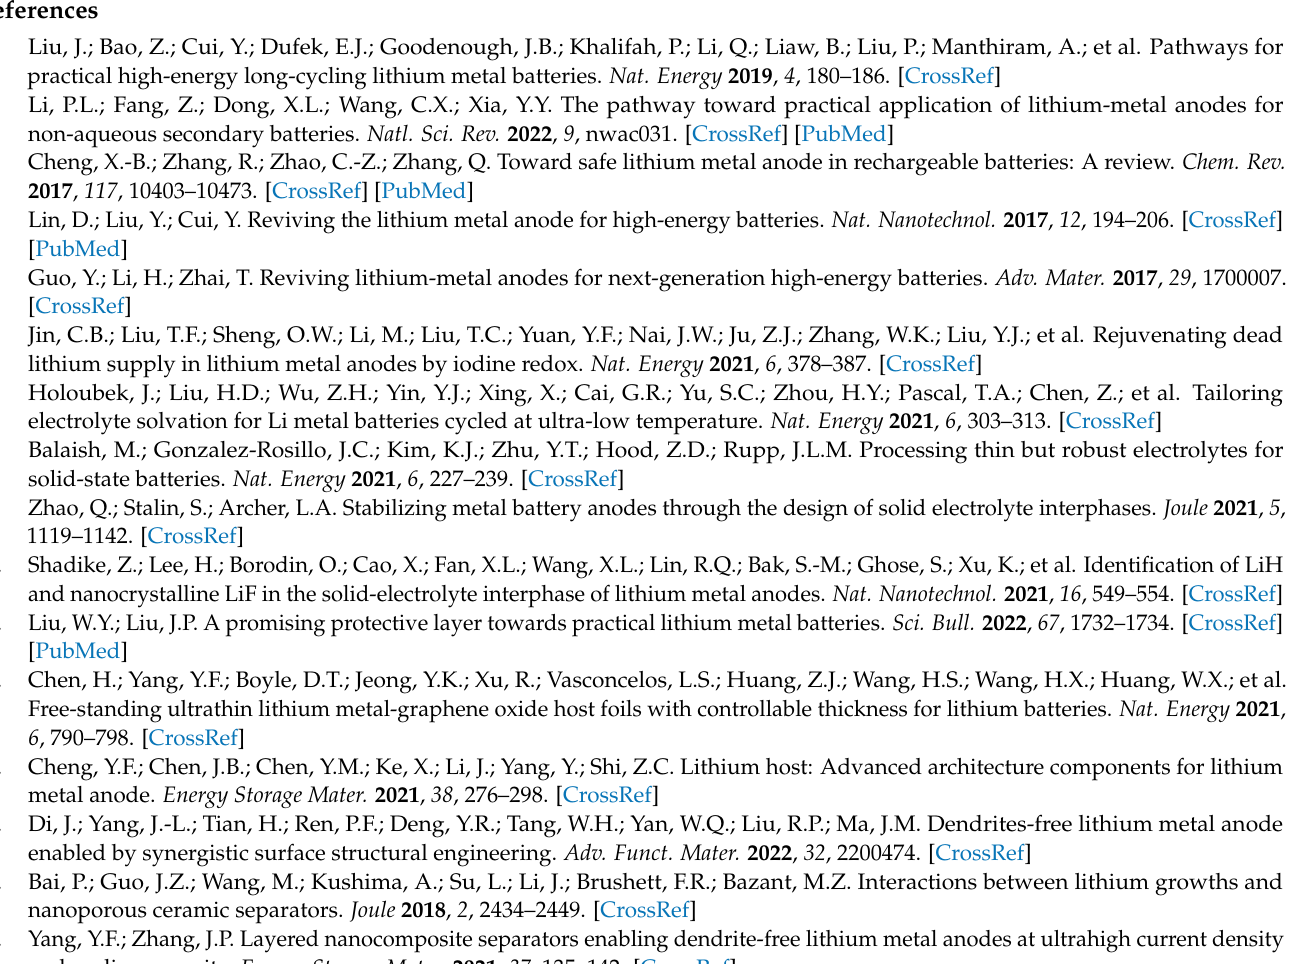
50 cycles; Figure S7: Voltage profiles of the full cells with the configuration of Cu foil-Li||LFP, CNTs@Cu foil-Li||LFP, and Au@CNTs@Cu foil-Li||LFP at different current